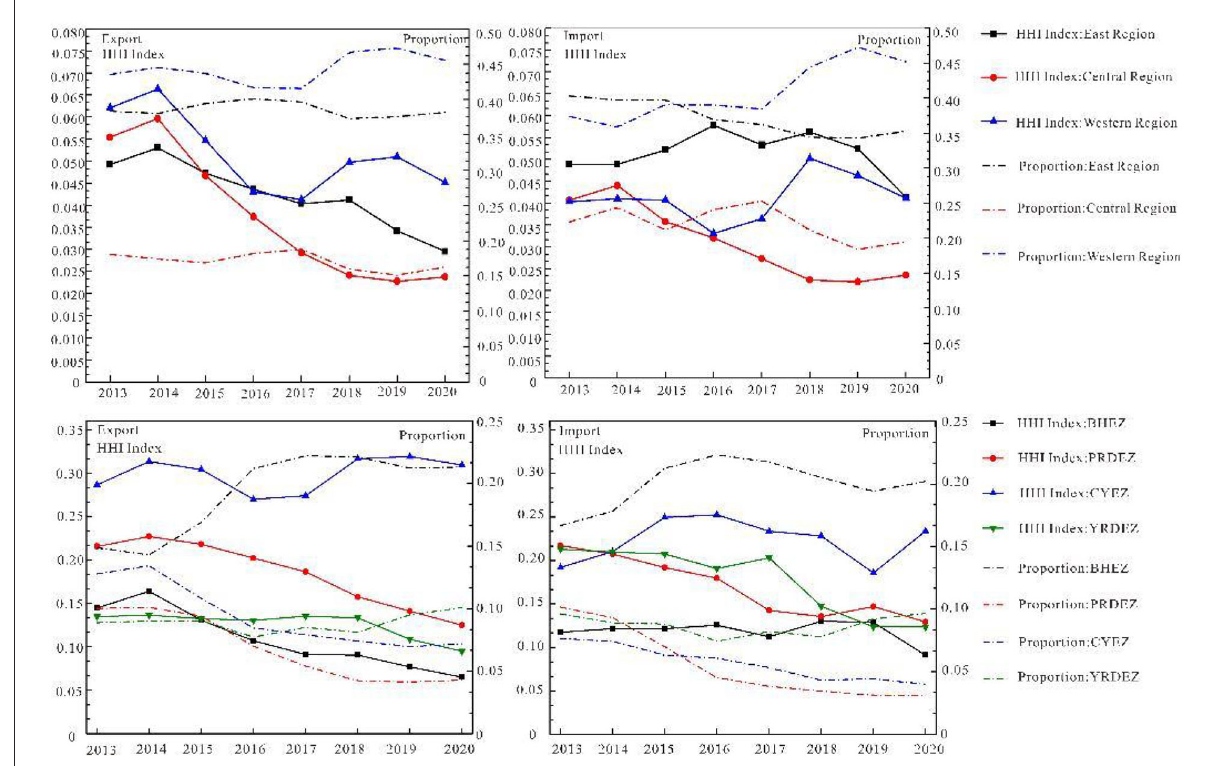
FIGURE8 Evolution of agglomeration effect in eastern, central, western regions and important economic regions.